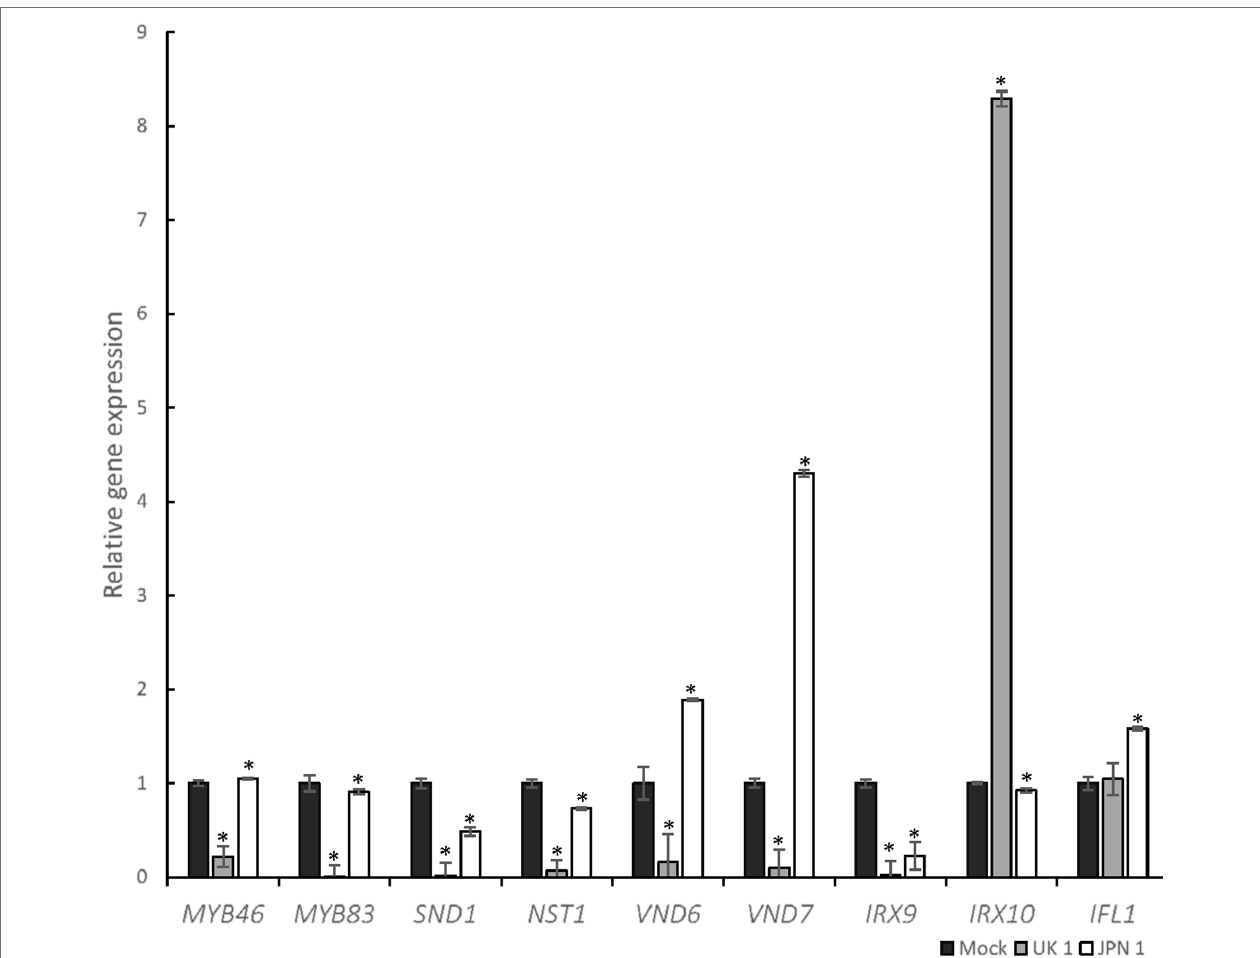
FIGURE 6 | Transcriptomic analysis of selected genes involved in SCW biosynthesis after TuMV infection. The graph shows the results of RT-qPCR of selected genes, represented as relative gene expression in JPN-1-infected or UK-1-infected strains of TuMV, compared to mock-inoculated plants. Comparisons are pairwise of each virus-infected and mock-inoculated. Genes analyzed and color-coded bars are shown in the figure. Asterisk indicates a significant difference compared with wild type (*p < 0.05 by t -test). Error bars show standard